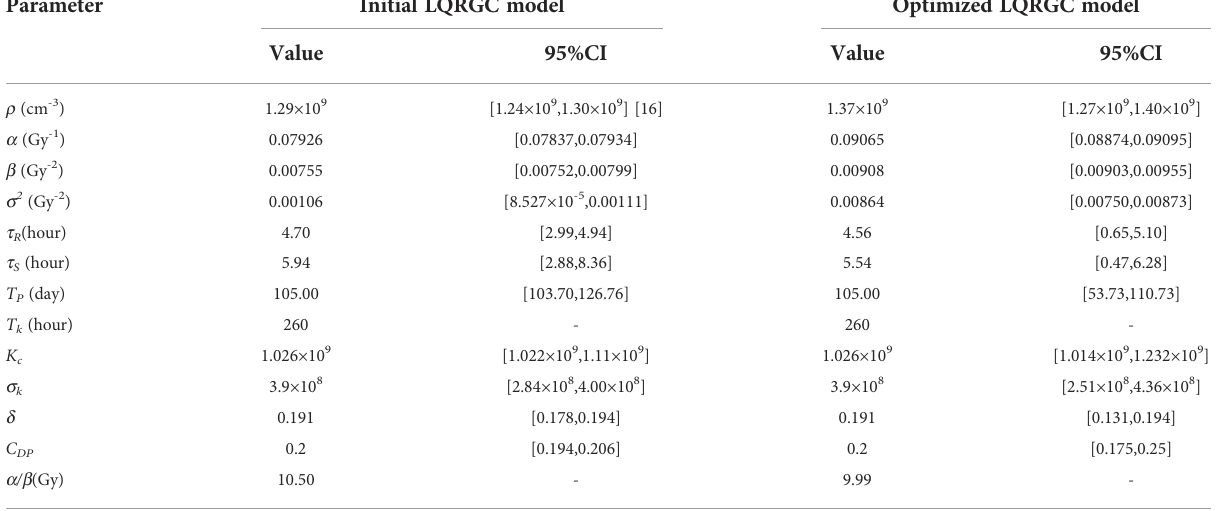
TABLE 4 The values of model parameters.